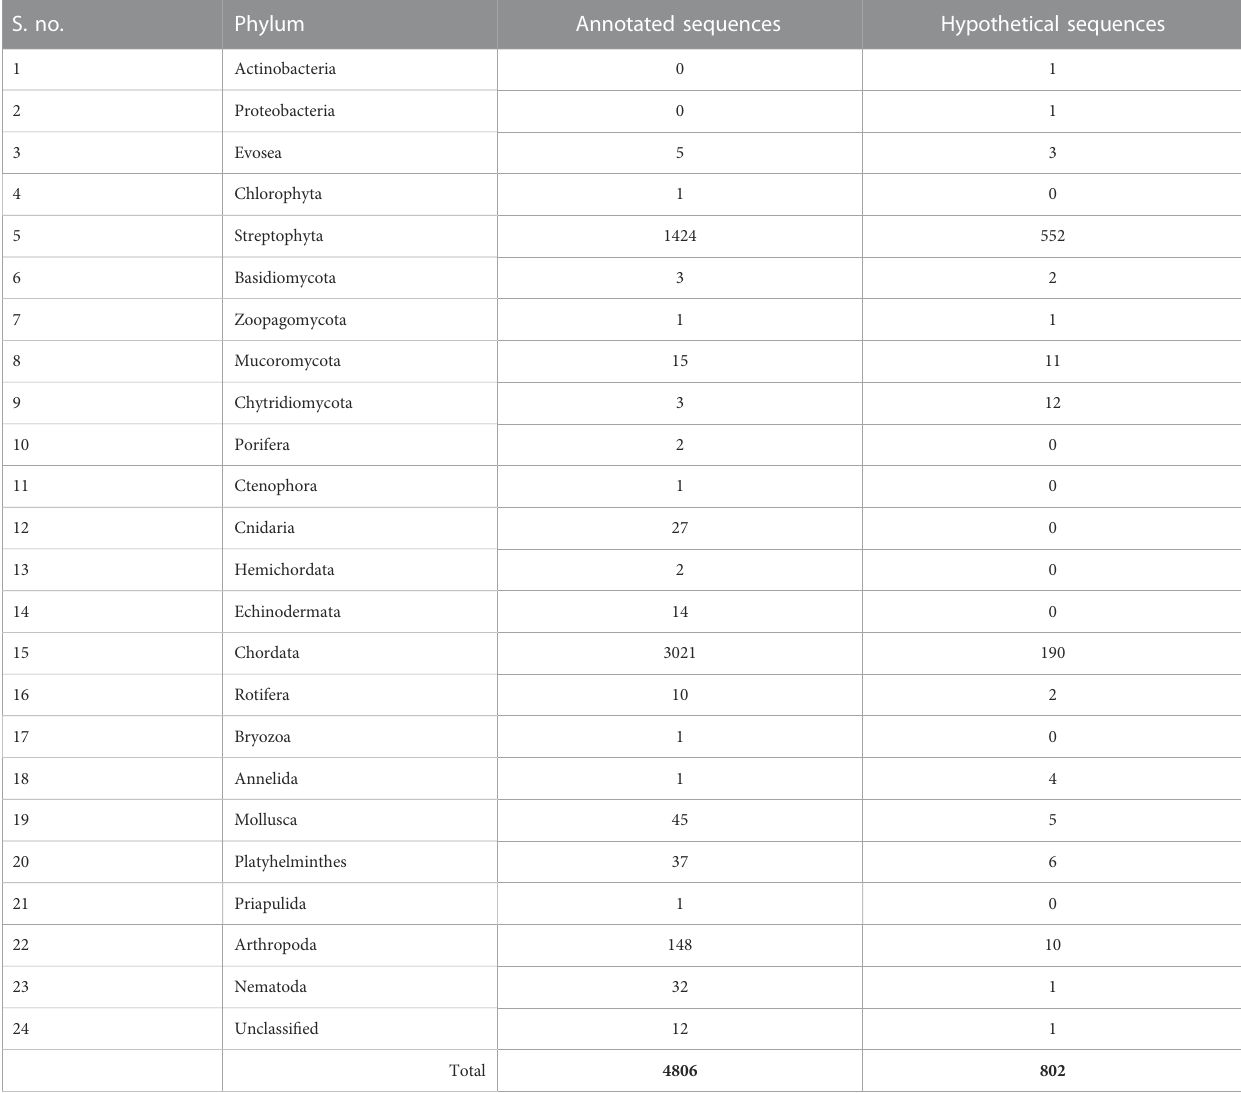
TABLE 1 List of number of annotated and hypothetical protein IDs observed in the taxonomy at the phylum level. S.